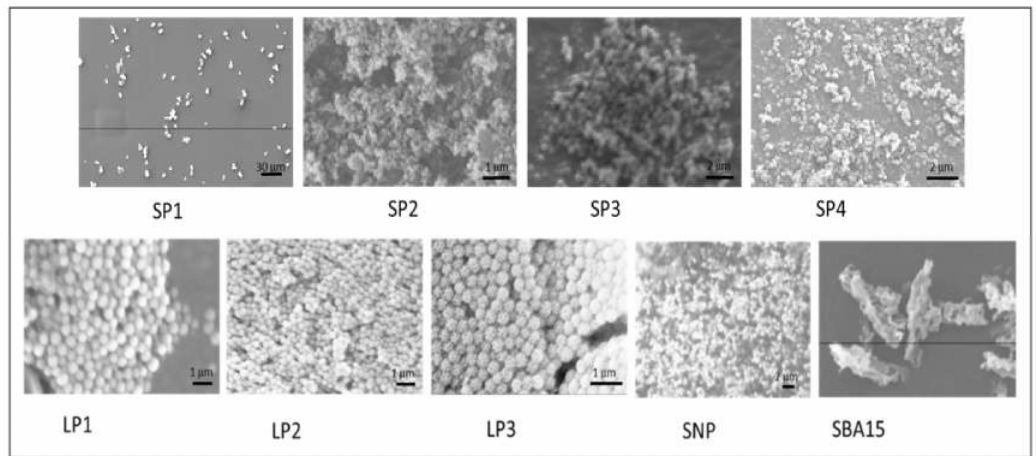
Figure 1. Characterization of synthesized silica nanoparticles using scanning electron microscopy. Solid nanoparticles (SNP) and SBA-15 are shown for comparison. Scale bars shown are (SP1) 30 µ m,